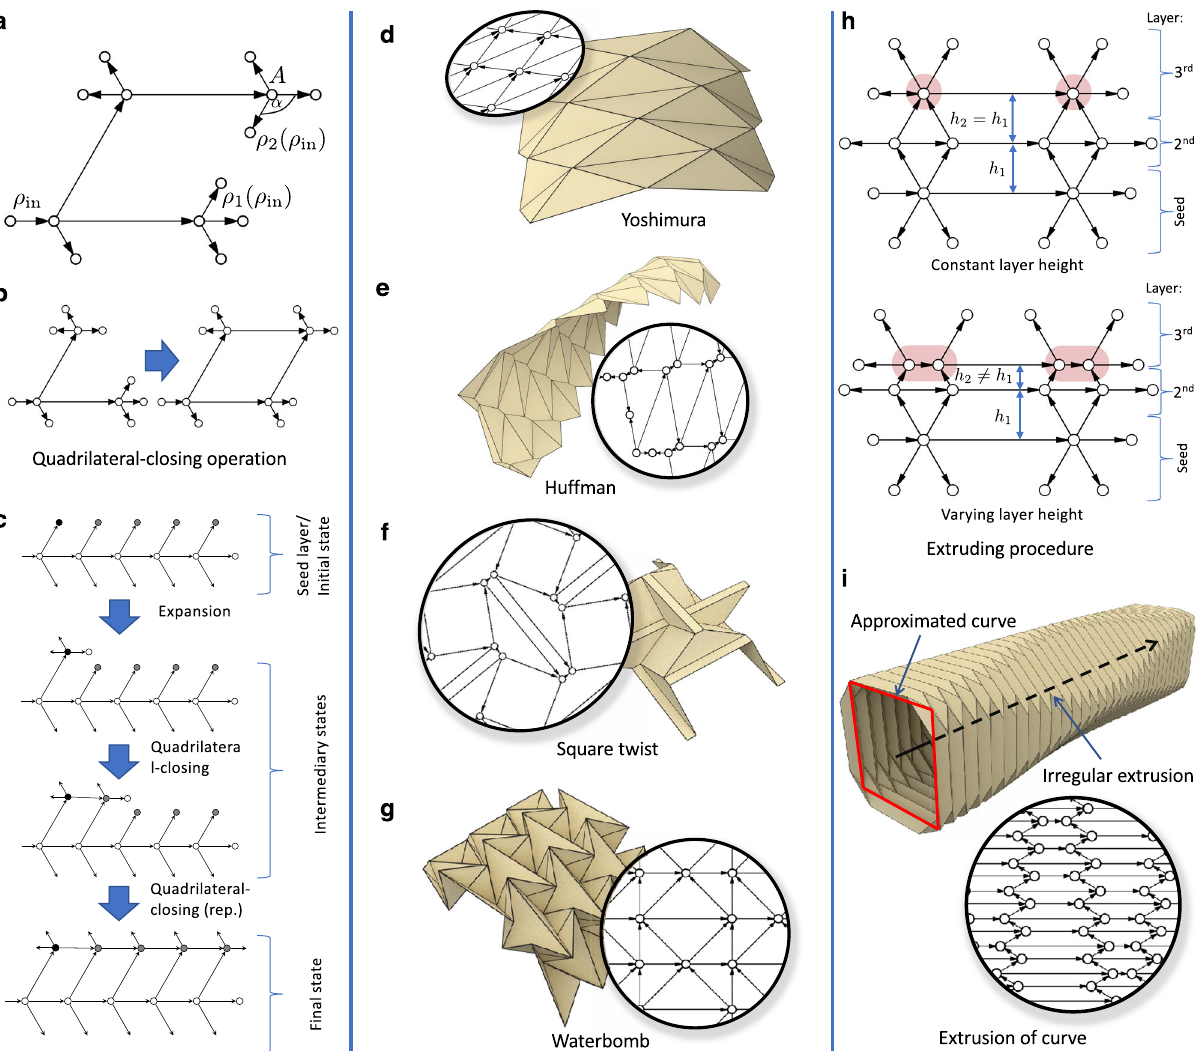
Fig. 3 Generating quadrilateral patterns. a Sample crease pattern graph. Selected relevant dihedral and sector angles are marked. b Application of the quadrilateral-closing operation. c Adding layers to a pattern (the shown example procedure generates the Miura-Ori pattern) by expanding vertices and applying the quadrilateral-closing operation. d – g Crease pattern graphs and folded con fi gurations various patterns: d Yoshimura ’ s pattern, e Huffman ’ s grid (auxiliary vertices are shown), f Square twist pattern, and g Waterbomb pattern. h Crease pattern graph of the extruded strip with constant and varying layer heights. i Crease pattern graph and folded con fi guration of a sample pattern obtained by irregular extrusion